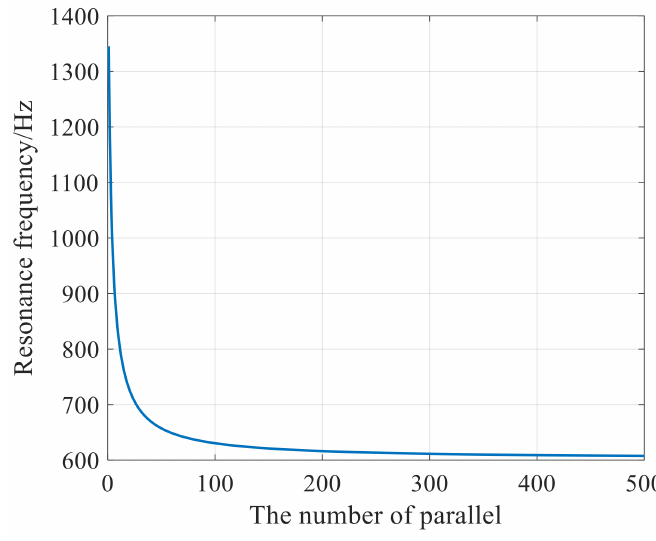
Figure 4. Relationship between resonance frequency and the number of parallel.